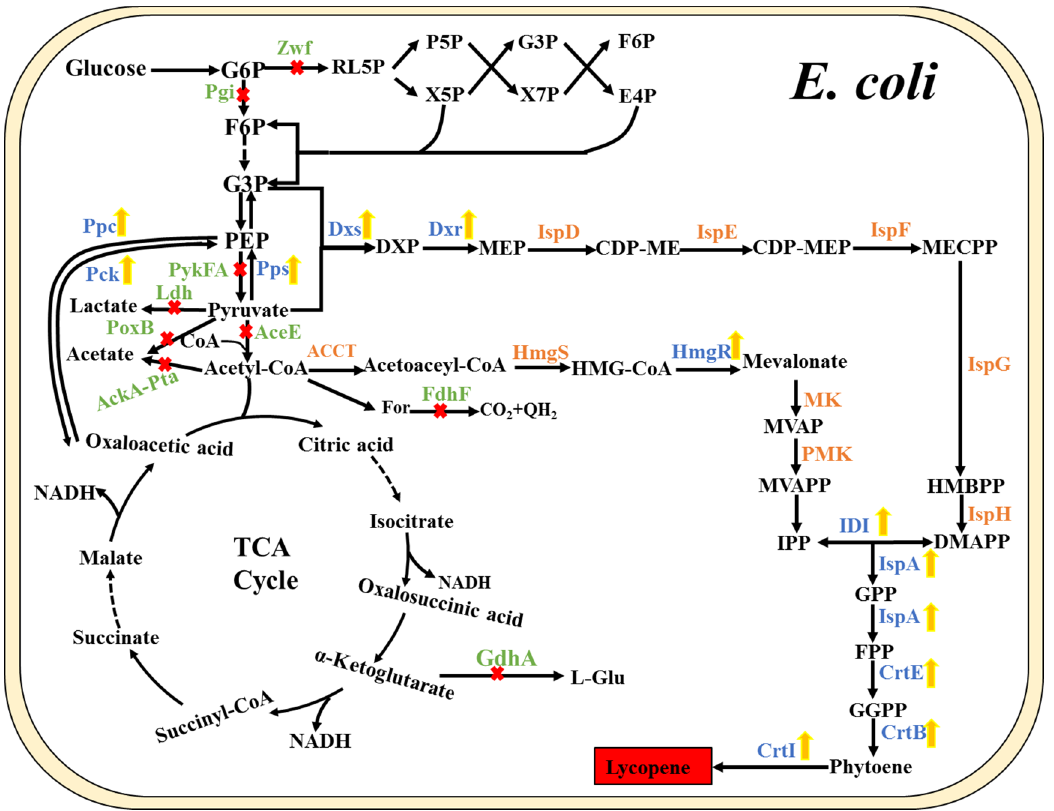
Figure 2. Metabolic engineering strategies of the entire lycopene pathway in E. coli . (The yellow arrow represents gene overexpression; the red “×” represents gene knockout or elimination of the pathway). Pps, phosphoenolpyruvate synthase; Pck, PEP carboxykinase; Ppc, PEP carboxylase; Ldh, lactate dehydrogenase; PoxB, pyruvate dehydrogenase; Ack, acetate kinase; Pta,